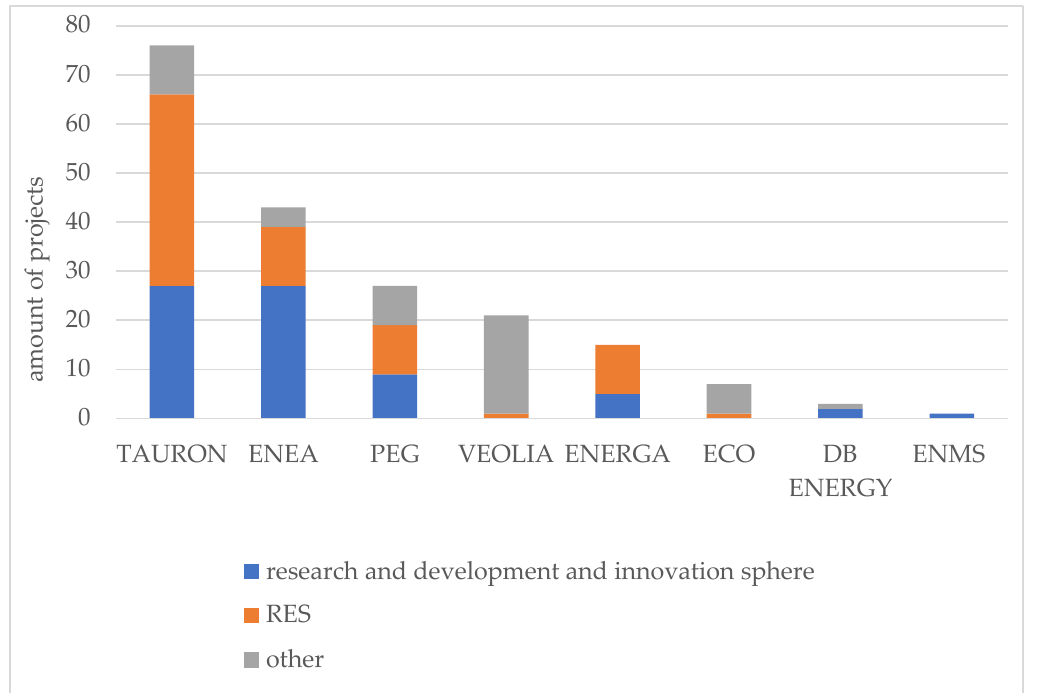
Figure 5. Share of innovative and renewable energy projects. Source: own compilation based on data from www.funduszeeuropejskie.pl (accessed on 10 March 2022).